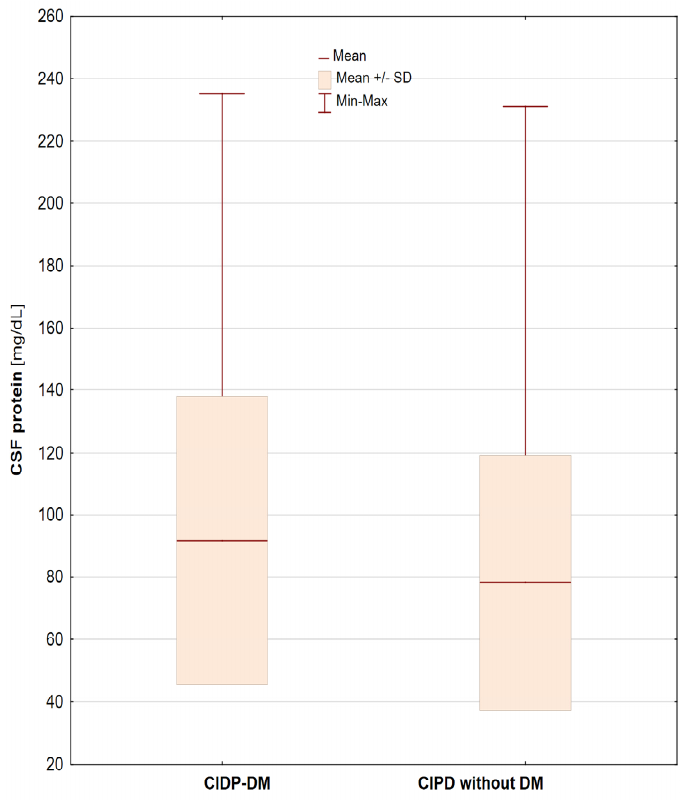
Figure 1. Distribution of lymphocyte subpopulations CD4+ and CD8+ in CIDP patients. Histograms of CD4+ lymphocytes Figure 3. Cerebrospinal fluid protein levels in CIDP patients with diabetes mellitus (CIDP-DM) and ( A ), and CD8+ lymphocytes ( B ) in cells/µL, and % of CD4+ lymphocytes ( C ), and CD8+ lymphocytes ( D) . without diabetes mellitus. Impaired CD4+ and CD8+ cell distribution resulted in significantly increased CD4+/CD8+ ratios (3.16 ± 2.18, range 2–14.3) in 42/60 patients. In healthy subjects, a normal range was found: monocytes 0–10% CD45+ leukocytes/200–900 cells/µL, lymphocytes 20– 45% CD45+ leukocytes/1500–4500 cells/µL, B CD19+ lymphocytes 11–16% lympho- cytes/60–660 cells/µL, T CD3+ lymphocytes 71–79% lymphocytes/770–2700 cells/µL, CD4+ lymphocytes 43–54% of T CD3+ lymphocytes/500–1500 cells/µL and lymphocytes CD8+ 28–37% of T CD3+ lymphocytes/270–930 cells/µL. In CIDP patients, IL-6 (10.18 ± 4.44 vs. 8.33 ± 2.65 pg/mL, p = 0.019), IL-2 (7.35 ± 0.83 vs. 6.54 ± 0.85 pg/mL, p = 0.0006) and IL-4 (7.98 ± 0.98 vs. 7.40 ± 1.33 pg/mL, p = 0.047), TNF- α (10.04 ± 11.12 vs. 9.99 ± 2.92 pg/mL, p = 0.009) levels were significantly increased (Table 3). The levels of other cytokines, i.e., INF- ƴ (Th1 cytokine) and IL-10, were compa- rable in both